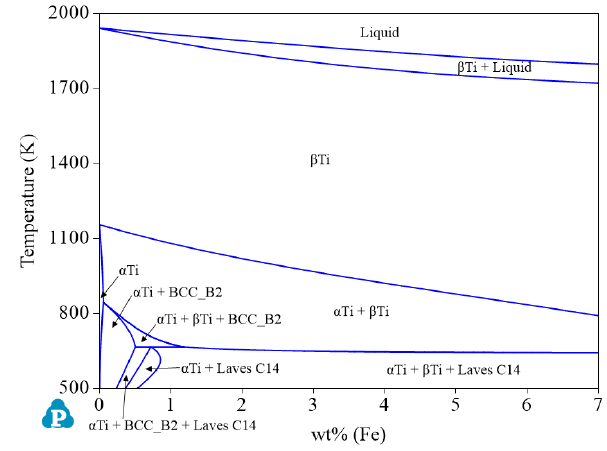
Figure 9. The calculated pseudo-binary section of V:Fe = 3.5:1 and 0.0 wt% Al.